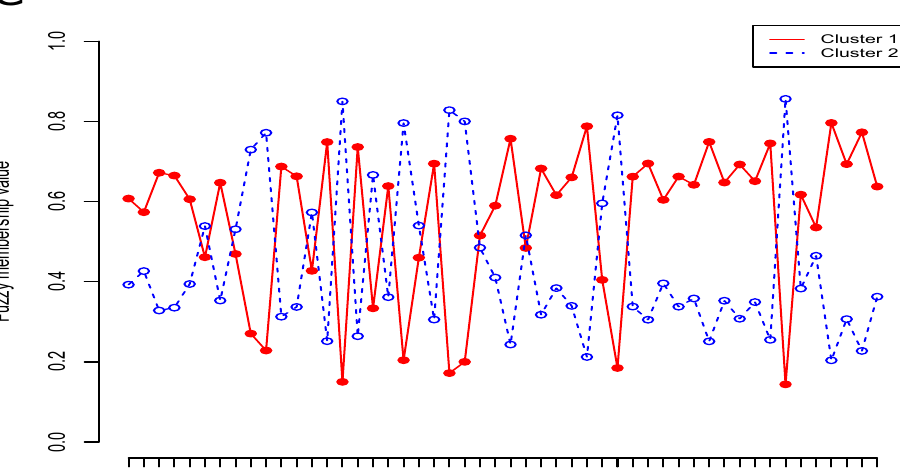
Figure 2. Plots of normalization and fuzzy membership. ( A ) Count-depth relation plot during SCnorm normalization for the scRNA-seq gene expression data. ( B ) Boxplot for the fuzzy membership scores of the cells for the two resultant clusters. ( C ) Fuzzy membership scores of the cells for the two resultant